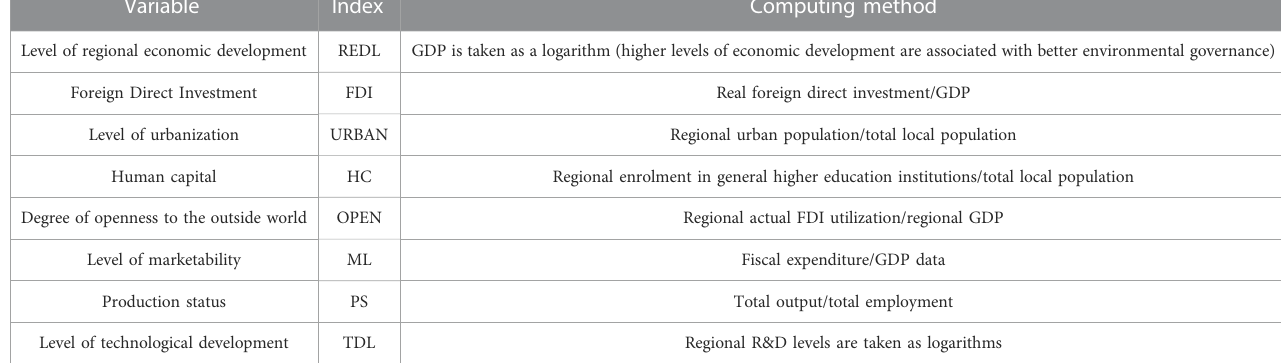
TABLE 2 Indicators of control